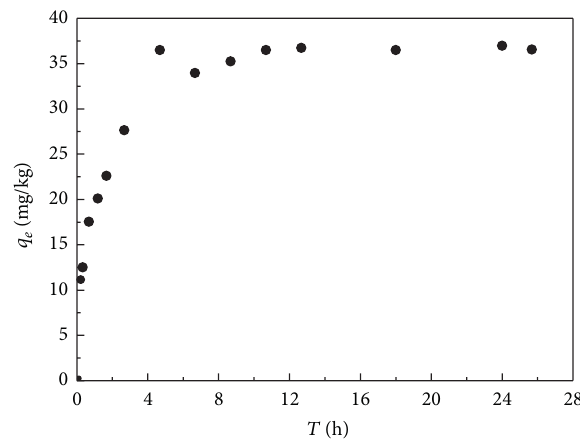
Figure 1: Adsorption kinetic curve of EE2 in the S3 sediment.